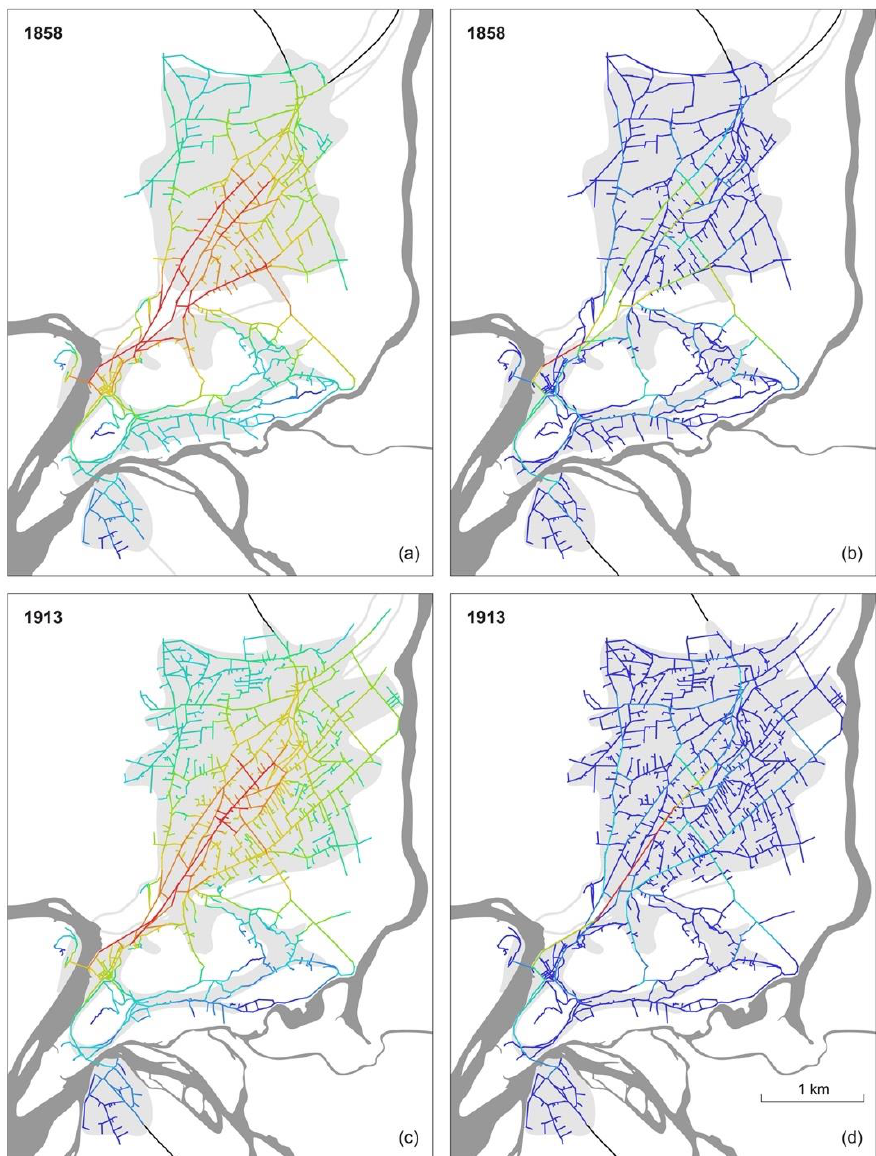
Figure 6 Axial map of Shkodër’s street network during the late Ottoman period after the diversion of Drin (1858) and the opening of new boulevards (1913) colored according to values of integration (a, c) and choice (b,